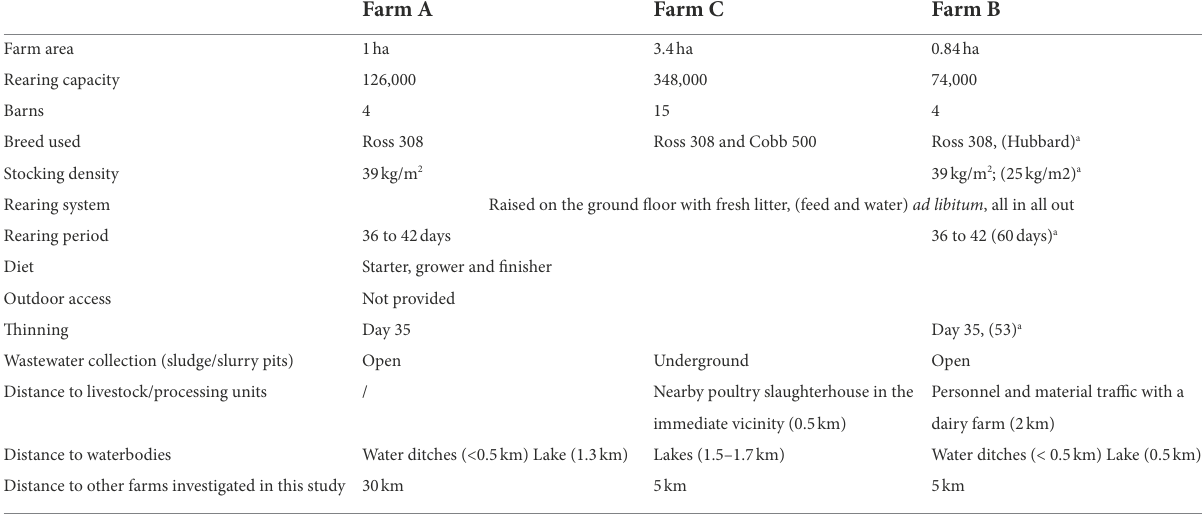
TABLE 1 Farm characteristics and broiler rearing conditions in Brandenburg, Germany,